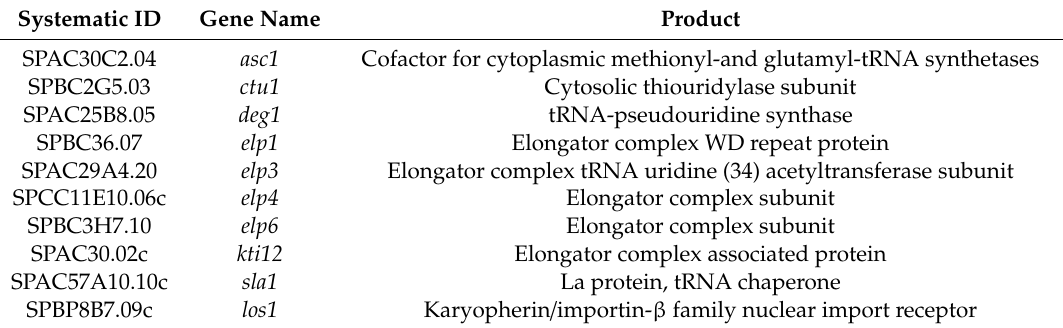
Table 1. tRNA-modification genes whose deletion causes rapamycin sensitivity in S. pombe